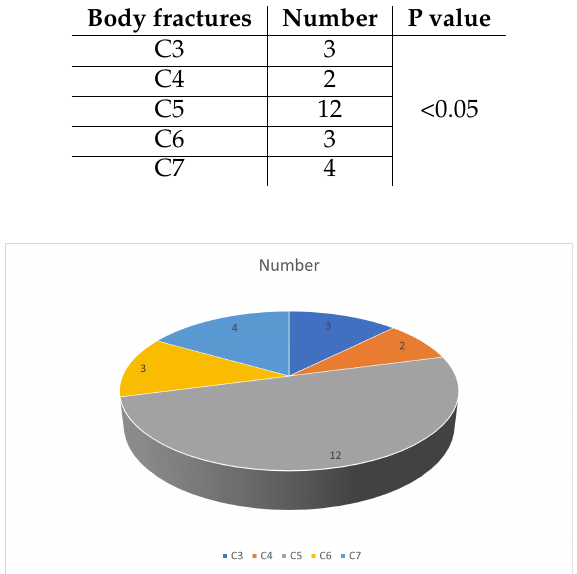
Table 4. Type of body fractures